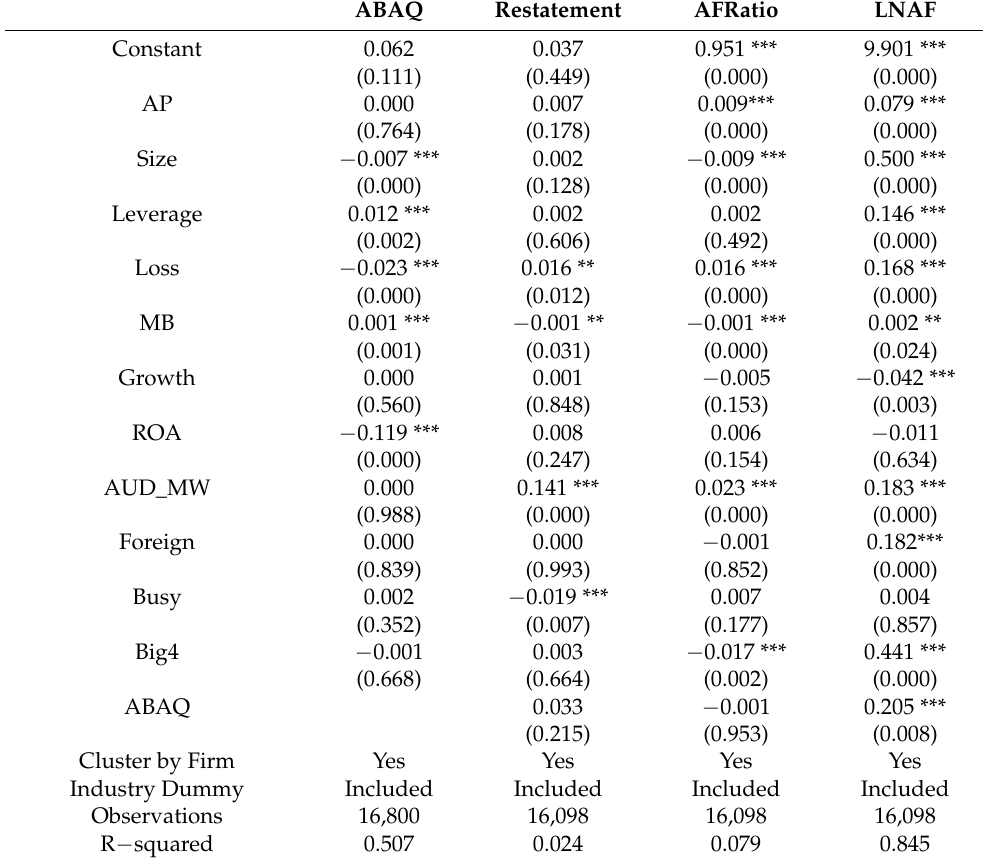
Table 4. Cont. Panel B : Three-year balanced panel designed ABAQ, Restatement, and AF of U.S. sample